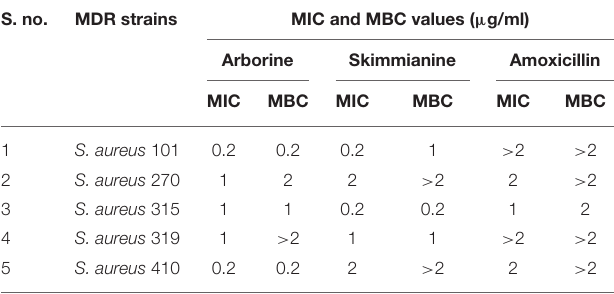
TABLE 6 | MIC and MBC values of arborine and skimmianine compounds against MDR S. aureus . S. no.